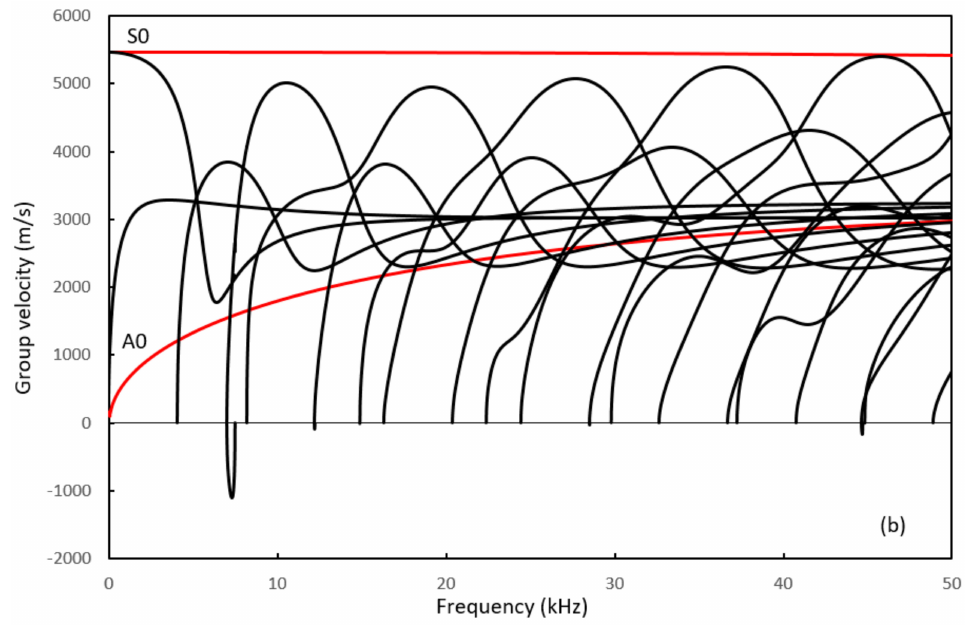
Figure 3. Dispersion curves for Lamb waves in an infinite plate: ( a ) phase velocity; ( b ) group velocity. Red line: 10 mm thickness; black line: 400 mm